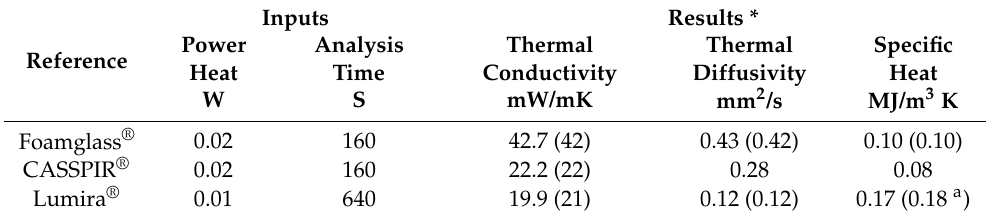
Table 1. Measurement conditions and thermal properties obtained for reference samples.